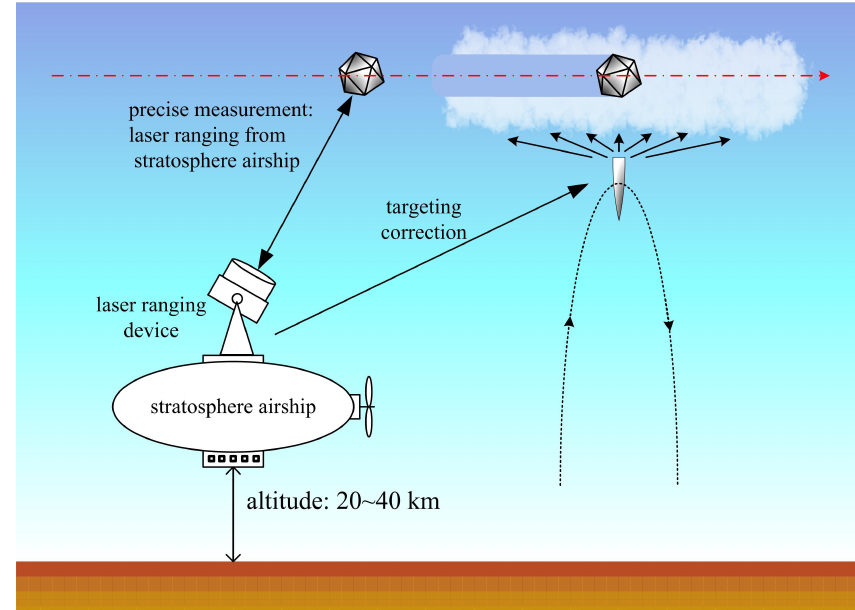
Figure 11. Stratospheric laser-ranging for